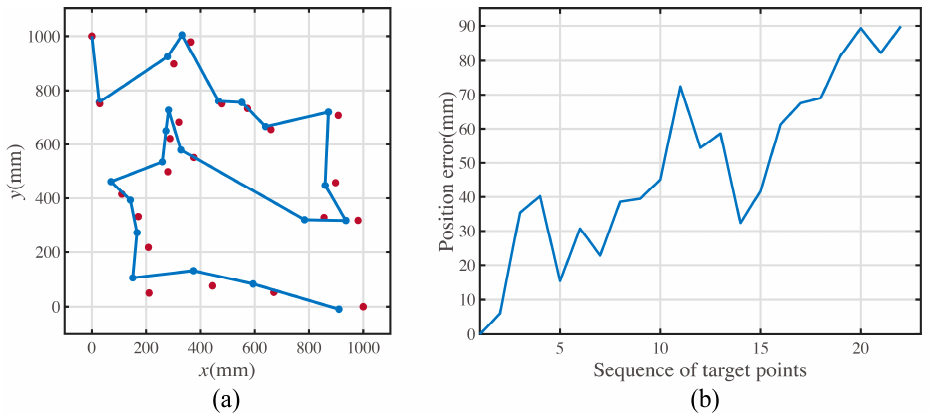
Figure 4. A realistic example of multiple-target position tracking. ( a ) Ideal positions and actual moving path in experiment. ( b ) Errors between the ideal positions and actual positions at each target point.